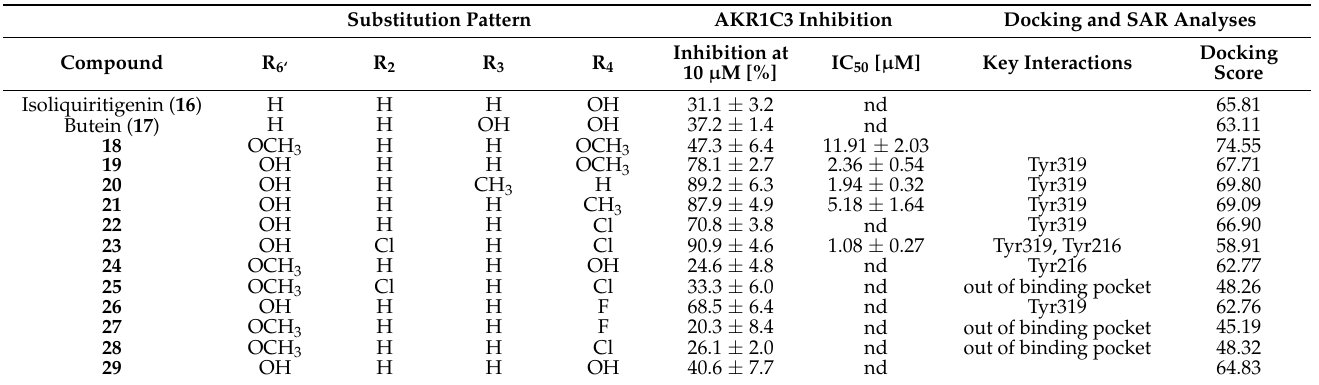
Table 1. Summary of chalcone backbone substitution pattern, inhibition of AKR1C3-catalysed ∆4-androstene-3,17-dione reduction, IC 50 values for AKR1C3 inhibition, and results for compound docking into the AKR1C3-binding site.